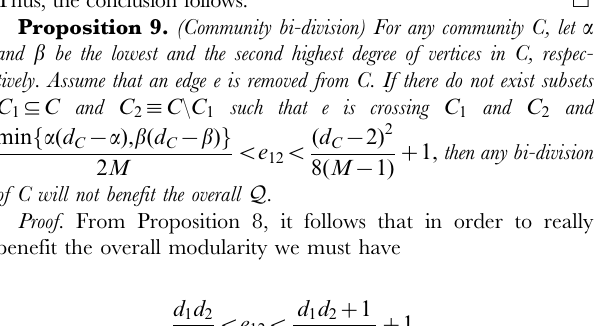
Table 4. Algorithm 4. Edge_Removal.